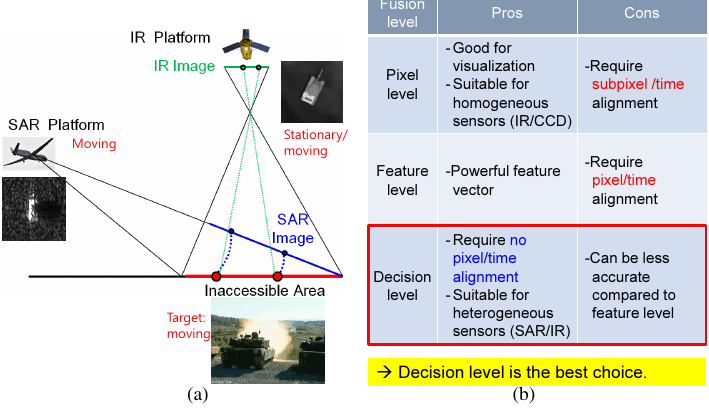
Figure 2. Necessity for decision-level SAR and IR sensor fusion: ( a ) operational concept of automatic target recognition; ( b ) pros and cons for each fusion